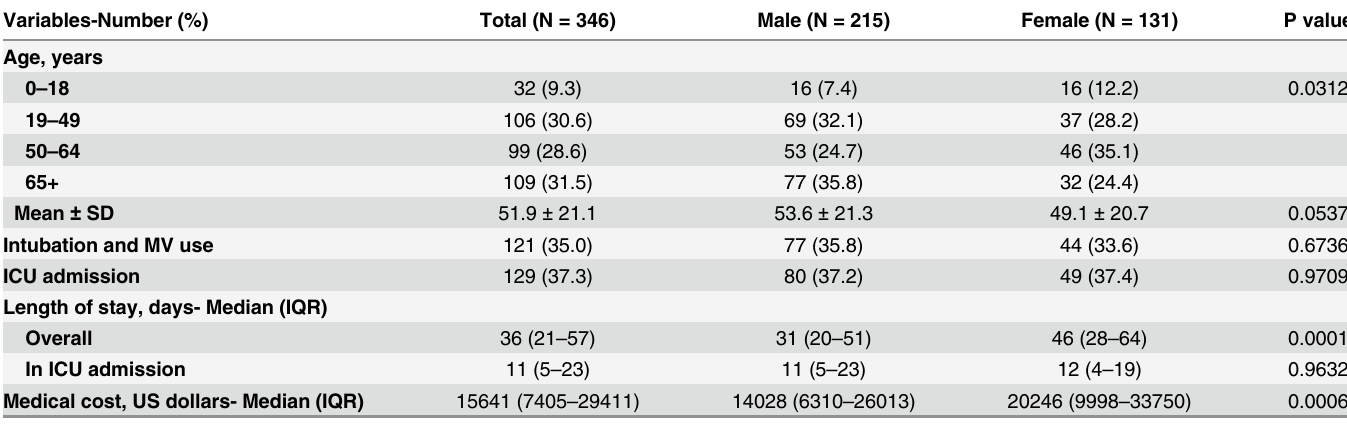
Table 1. Demographic characteristics, clinical features, and resource utilizations of patients with invasive aspergillosis pneumonia. Variables-Number (%)